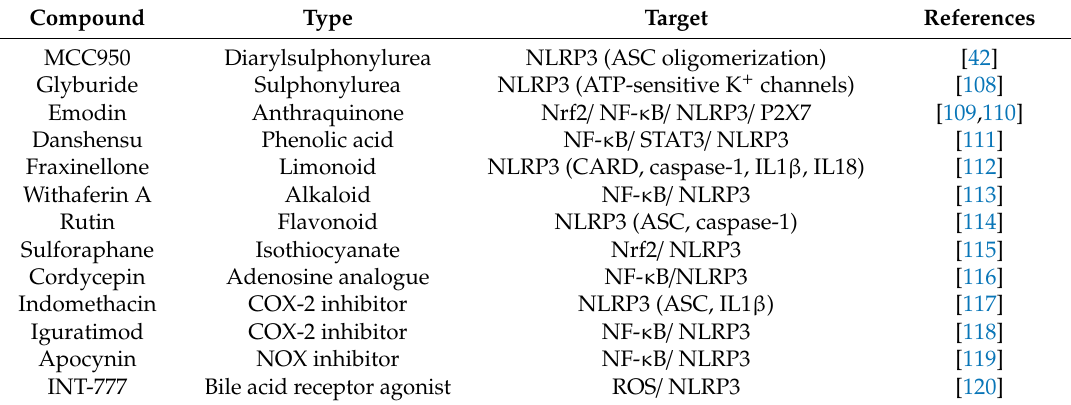
Table 1. Inhibitory compounds of NLRP3 inflammasome activation in acute pancreatitis. Compound Type